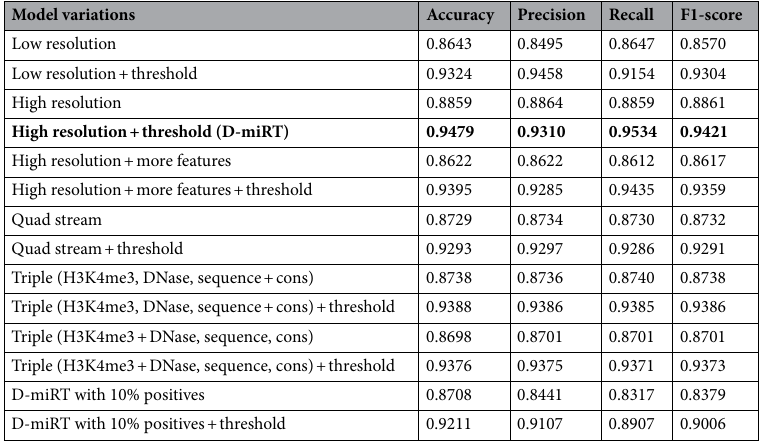
Table 2. Performance of D-miRT in comparison to the model variations.